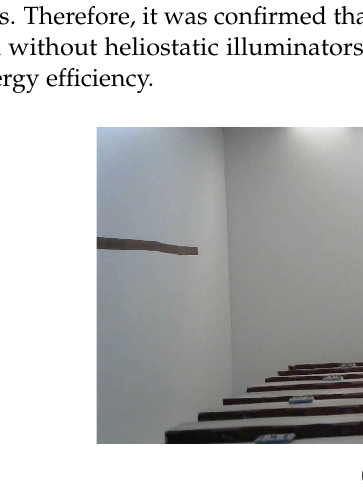
Figure 15. Scale models place outdoors. ( a ) Scale model arrangement and data acquisition system ( b ) Solar rays’ trajectory.